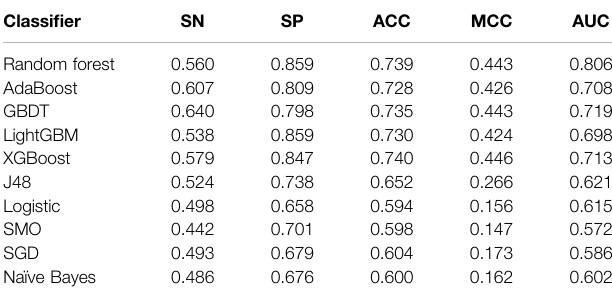
TABLE 5 | Performance of various classi fi ers based on AAC-DDE-GDC-gap1 feature on the independent dataset. Classi fi er SN SP ACC MCC Random forest